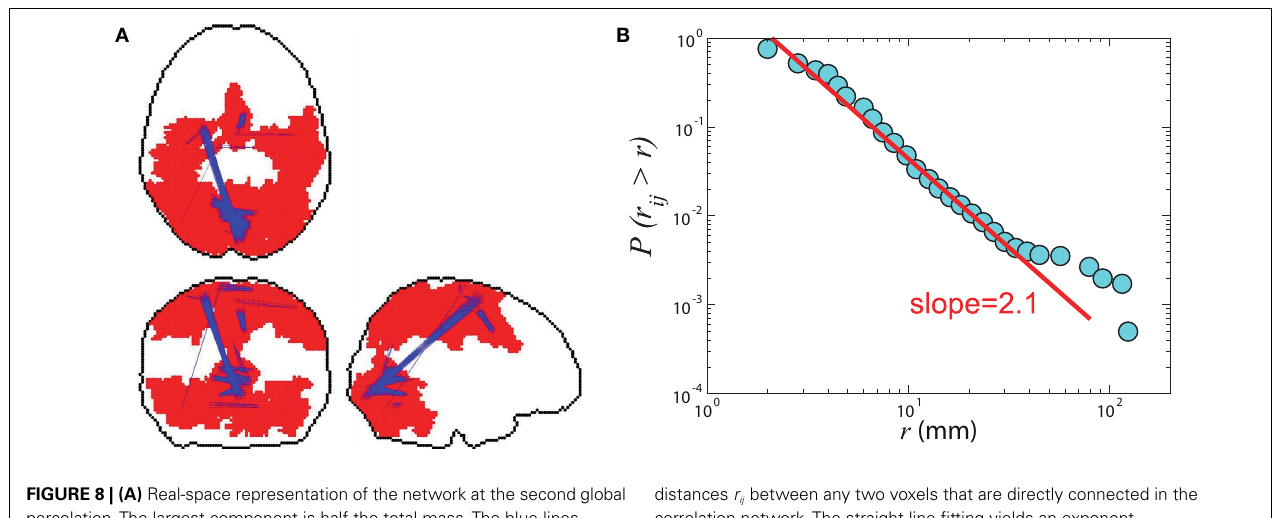
distances r ij between any two voxels that are directly connected in the correlation network.The straight line fitting yields an exponent α − 1 = 2.1 ± 0.1 indicating optimal information transfer with wiring cost